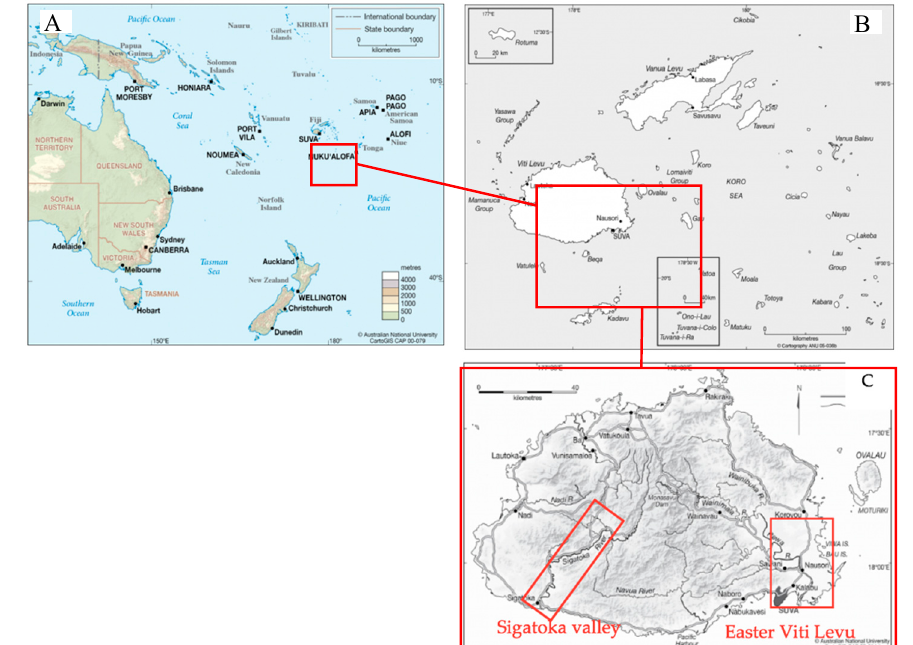
Figure 1. Map of the Fiji Islands. ( A ) Location of the Fiji Islands relative to countries within close proximity. ( B ) Map of Viti Levu Island within the Fiji Islands group. ( C ) Map of the two study sites on Viti Levu where farmer surveys were undertaken. (Map source: CartoGIS Services, College of Asia and the Pacific, The Australian National University, Australia, 2019).